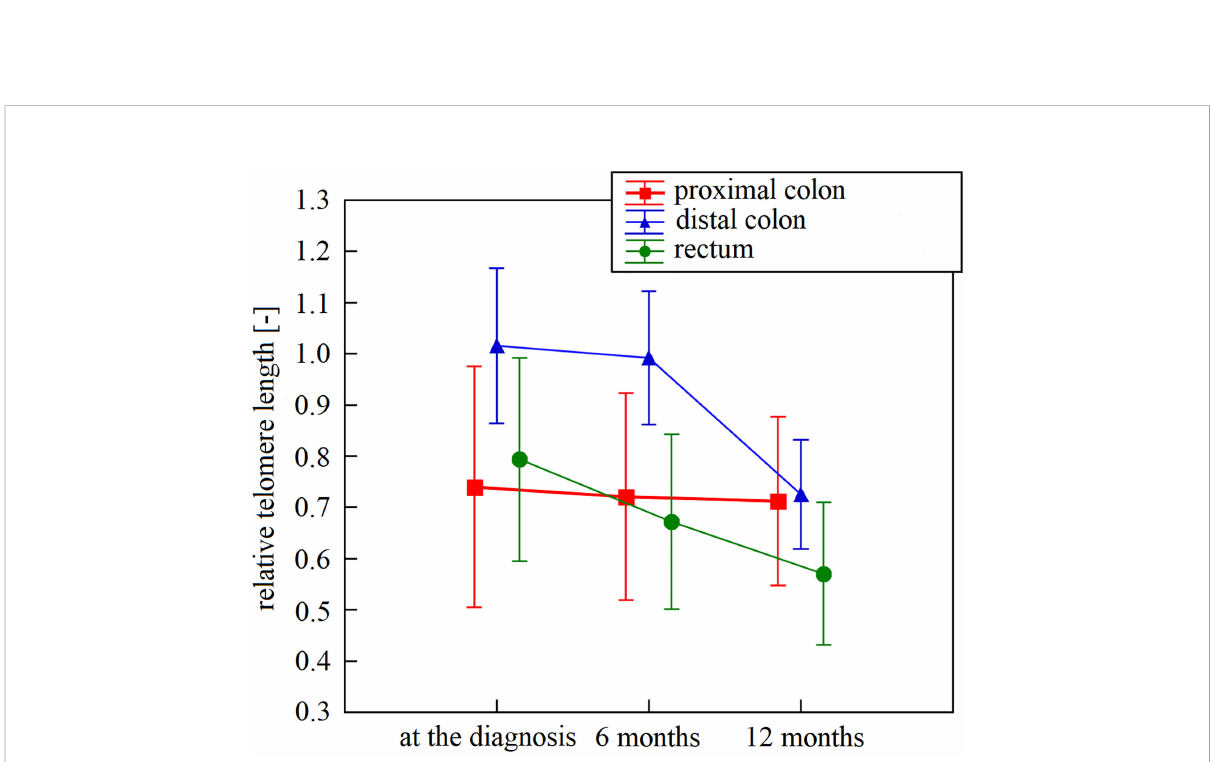
FIGURE 2 Leukocyte telomere length within 12 months after diagnosis in patients strati fi ed according to their tumor localization. Leukocyte telomere length curve had a different trajectory in patients diagnosed with proximal colon (n = 11), distal colon (n = 24), and rectal cancer (n = 14; p = 0.03). Vertical bars denote 0.95% CI. N represents the number of patients for whom all intervals were